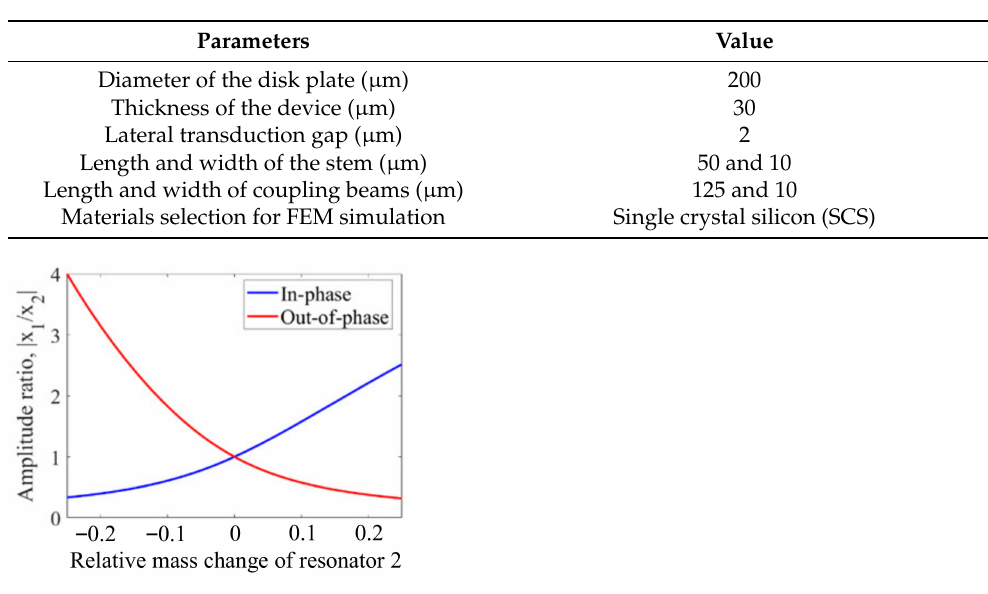
Figure 12. A 2-DoF weakly coupled BAW disk resonator system with mode localization simulated in COMSOL. ( a ) Out-of-phase mode without perturbation; ( b ) Out-of-phase mode with a small mass perturbation on the right resonator; ( c ) In-phase mode without perturbation; ( d ) In-phase mode with a small mass perturbation on the right resonator. Table 7. Dimensions and materials of a 2-DoF weakly coupled BAW disk resonator system modeled in COMSOL.